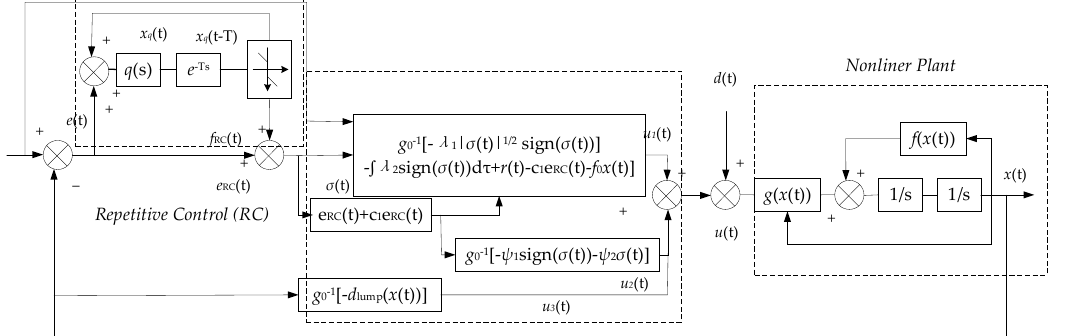
+ clearance clearance Figure 11. Block diagram of a dual-motor driving servo system. Chuei and Cao [72] proposed an extreme learning machine-based super-twisting repetitive control (ELMSTRC), as shown in Figure 12, to improve the performance of tracking periodic signals as well as to compensate for viscous friction and nonlinear friction. First, repetitive control was designed to track a periodic reference and